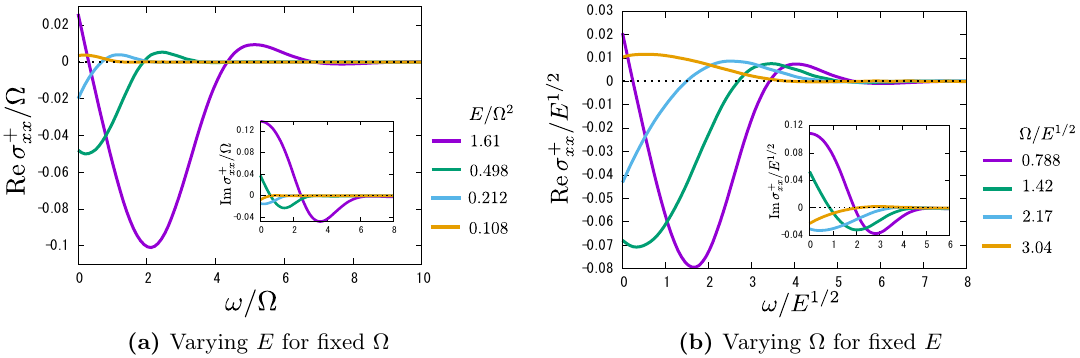
Figure 12. Conductivity (cid:27) +